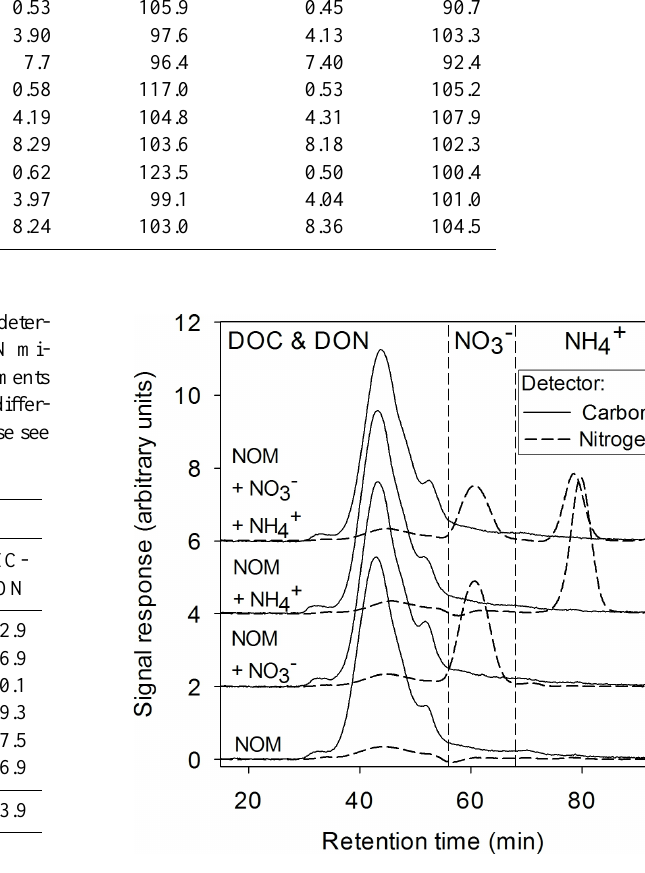
Fig. 3. Size-exclusion chromatograms of Fuchskuhle natural or- ganic matter (NOM) with added NO − ble 1 for further details on the